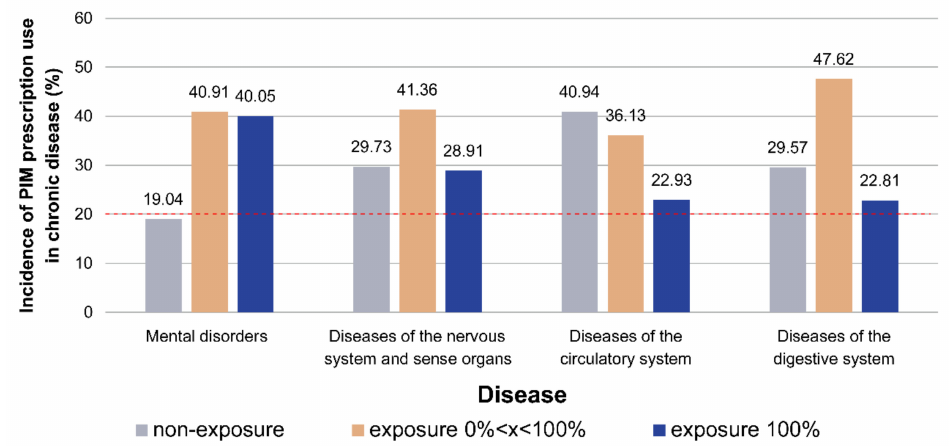
Figure 2. Chronic diseases for which there was a 100% continuous long-term exposure to PIM prescription rate of > 20%, shown at exposure rates of 0%, 0% < x < 100% and 100%.